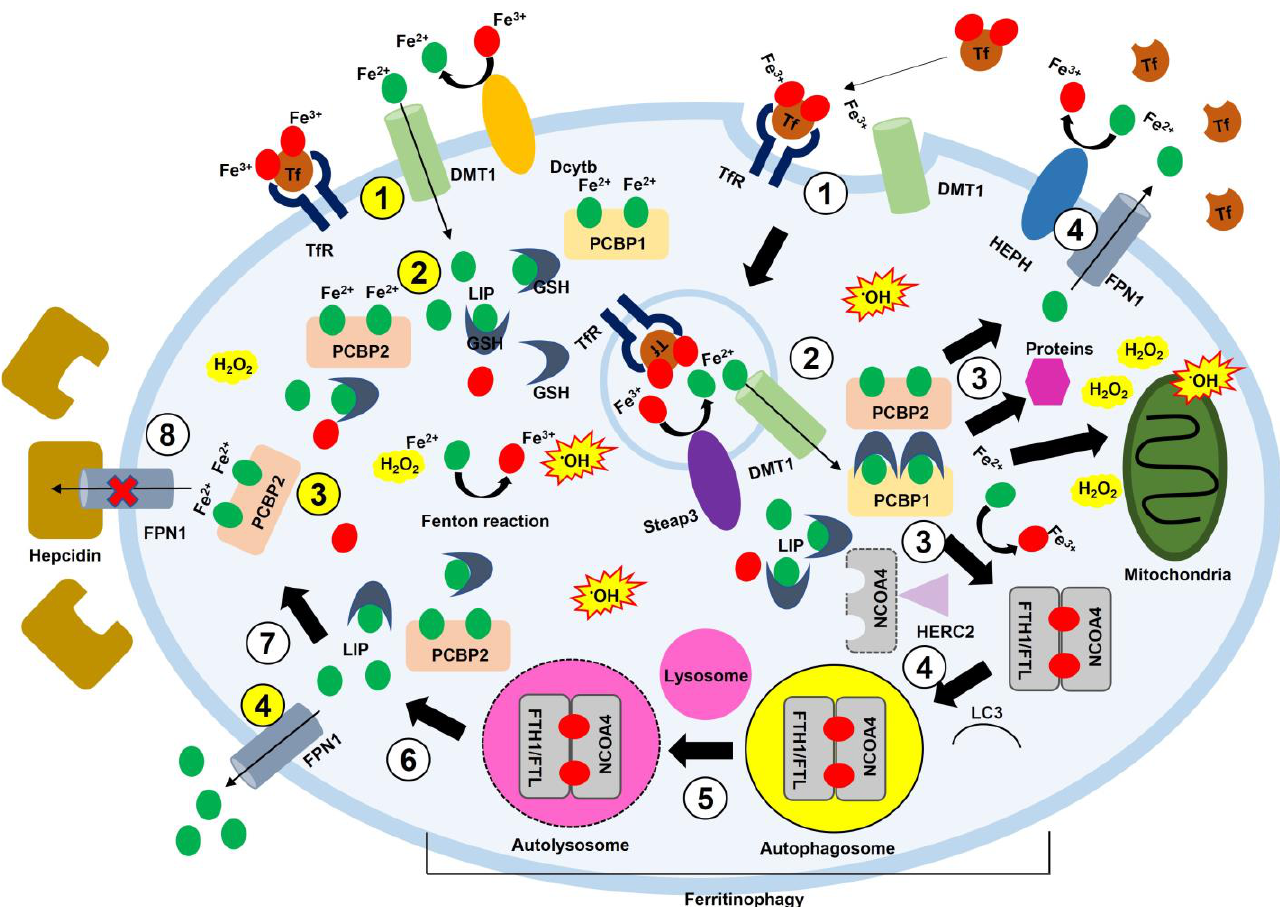
Figure 2. Cellular iron regulation in ferritinophagy. Fe 3+ is reduced to Fe 2+ via Dcytb, and Fe 2+ is then transported into cells via Tf–Tfr or DMT1. Oxidized Fe 3+ is encapsulated by vesicles called endosomes. Next, Steap3 in the vesicles reduces Fe 3+ to Fe 2+ and releases it into the cytoplasm. Fe 2+ binds to PCBP1 or PCBP2 and is delivered to FTH1, the mitochondria, or FPN1. FTH1 interacts with NCOA4 to store iron. Meanwhile, the interaction between hepcidin and FPN1 blocks the leakage of intracellular iron. When iron is deficient, the FTH1–NCOA4 complex releases iron through ferritinophagy. When iron is repleted, FPN1 exports iron into the extracellular space. In the extracellular space, Fe 2+ is oxidized to Fe 3+ by HEPH. Intracellular iron responds to H 2 O 2 and produces • OH. ROS damages organelles. A white circle with numbers means iron movement by endocytosis. A yellow circle with numbers shows iron movement through a channel. DMT1, divalent metal transporter 1; DcytB, duodenal cytochrome B; Fe 2+ , ferrous iron; Fe 3+ , ferric iron; FTH1, ferritin heavy chain; FTL, ferritin light chain; FPN1, ferroportin 1; GSH, glutathione; HEPH, hephaestin; HERC2, HECT domain and RCC1-like domain 2; • OH, hydroxyl radical; H 2 O 2 , hydrogen peroxide; LC3, microtubule-associated protein 1A/1B-light chain 3; LIP, labile iron pool; NCOA4, nuclear receptor coactivator 4; PCBP1, poly(rC)-binding protein 1; PCBP2, poly(rC)-binding protein 2; ROS, reactive oxygen species; Steap3, six-transmembrane epithelial antigen of prostate family member 3; Tf, transferrin; TfR, transferrin